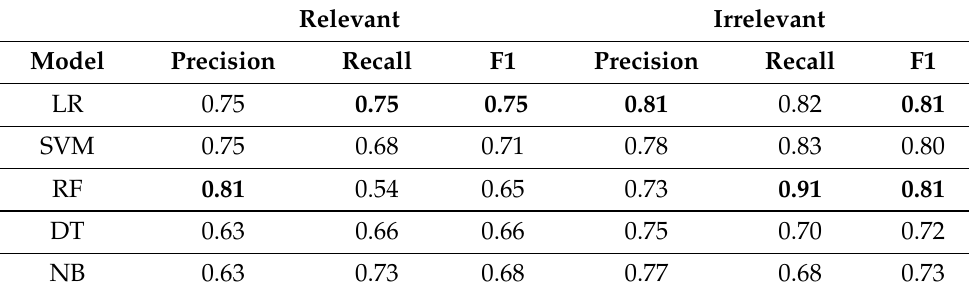
Table 1. Tweet classification accuracy: Relevant vs. Irrelevant.